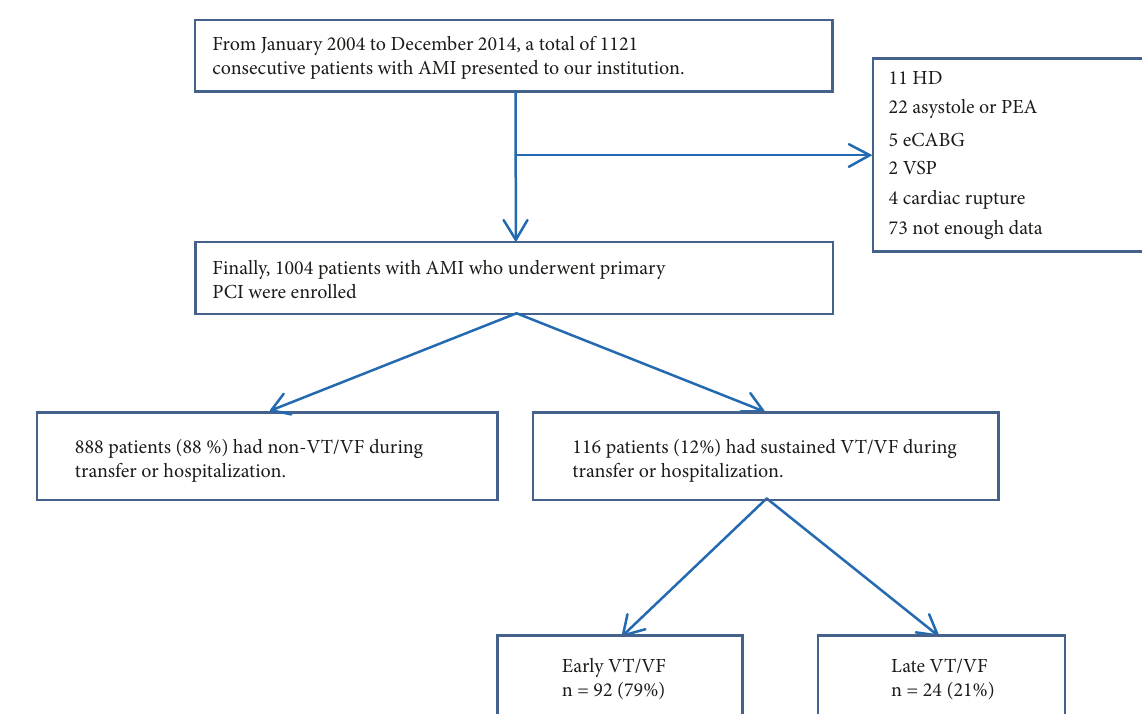
Figure 1: Study flow chart. eCABG: emergent coronary bypass graft surgery, HD: hemodialysis, PCI: percutaneous coronary intervention, PEA: pulseless electrical activity, VSP: ventricular septal perforation, VT/VF: ventricular tachycardia or ventricular fibrillation.